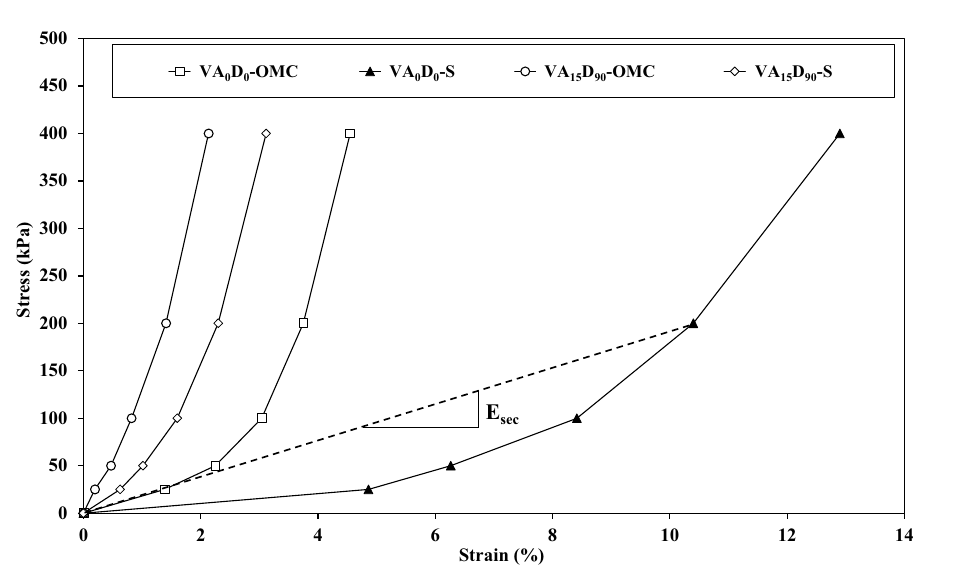
Figure 10. One-dimensional compression stress–strain